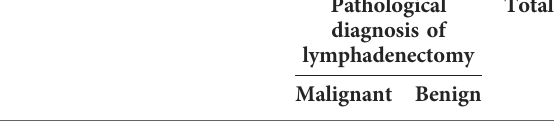
TABLE 6 Clinical evaluation of modi fi ed needle aspiration biopsy in the diagnosis of lymphadenopathy.